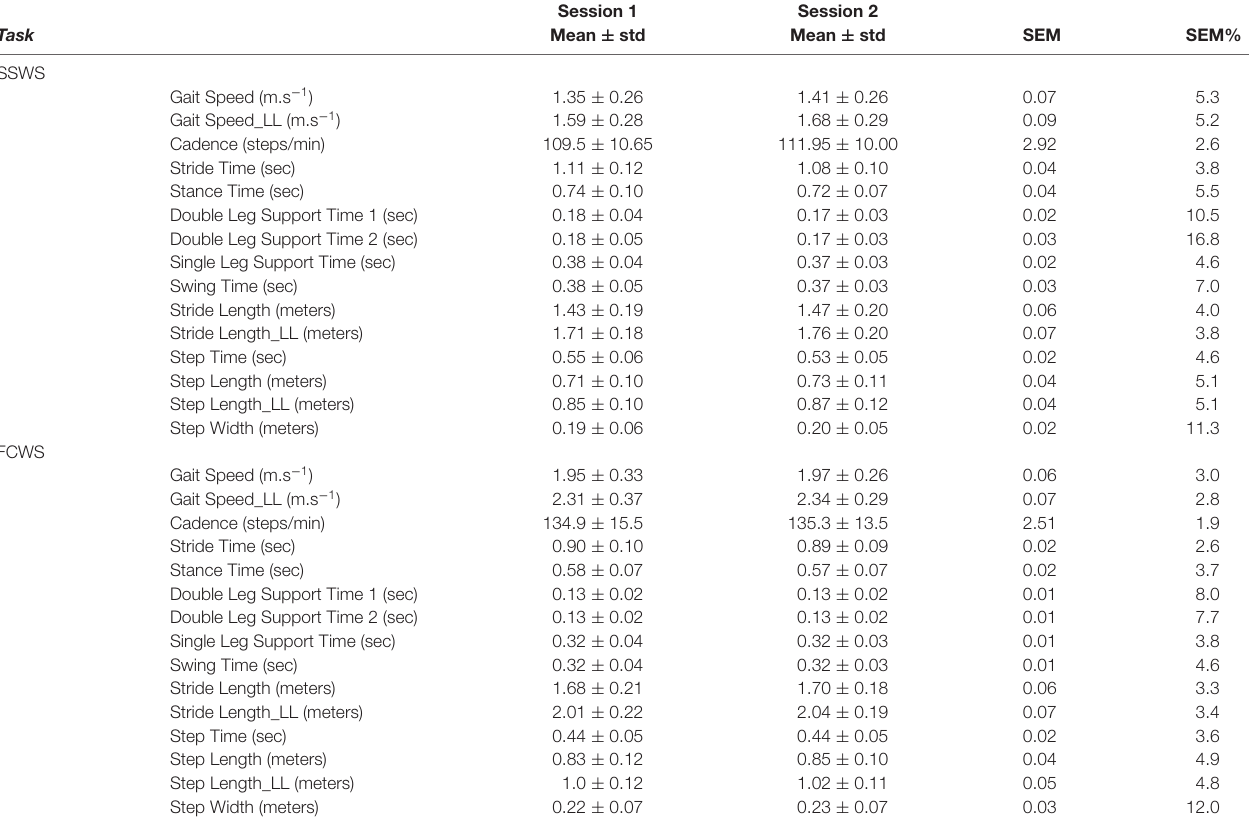
TABLE 9 | Mean ± standard deviation (std) of the variables for both sessions (session 1 and session 2) along with Standard Error of Measurement (SEM), and percentage of Standard Error of Measurement expressed from the mean (SEM%) of Spatio-temporal variables during both self-selected walking speed (SSWS) and fastest comfortable walking speed